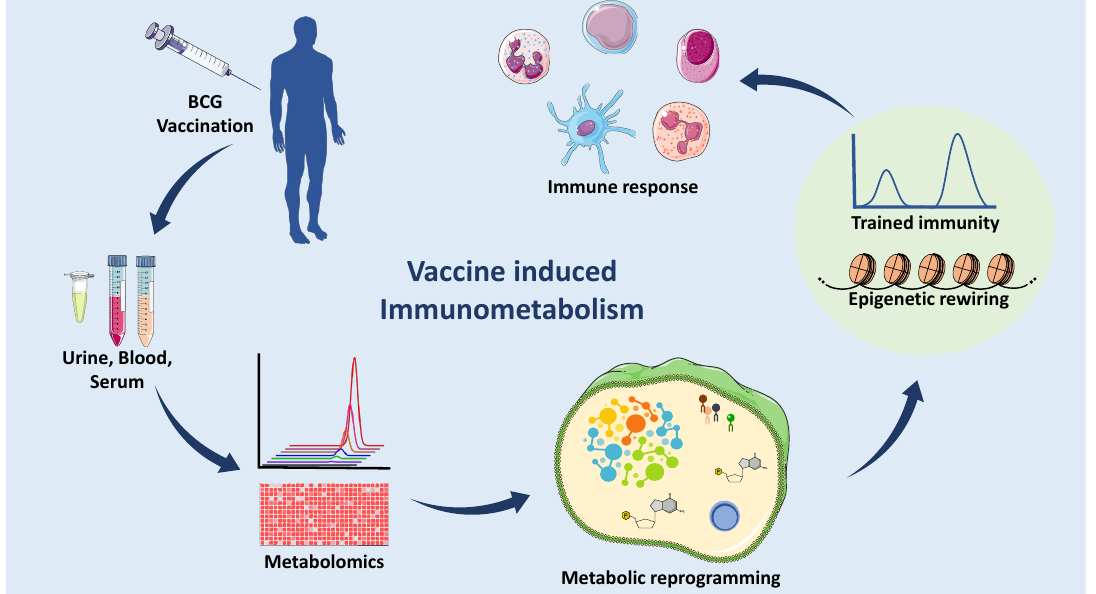
Figure 1. Analyzing Immunometabolomic effects of TB vaccination. In a clinical setup, body fluids (such as blood serum or plasma and urine) would be collected and processed to run on a GC-MS or LC-MS to profile the levels of the metabolites and then analyzed various bioinformatic tools. Quantitative analysis shows the changes in different pathways as compared to placebo subjects. A correlation has been shown between metabolic remodeling, trained immunity, and epigenetics. These may potentiate the effect of the vaccine to mount a better immune response. (Abbreviations: GC-MS: Gas chromatography-mass spectrometry, LC-MS: Liquid chromatography-mass spectrometry.) (The figure was partly generated using Servier Medical Art, provided by Servier, licensed under a Creative Commons Attribution 3.0 unported